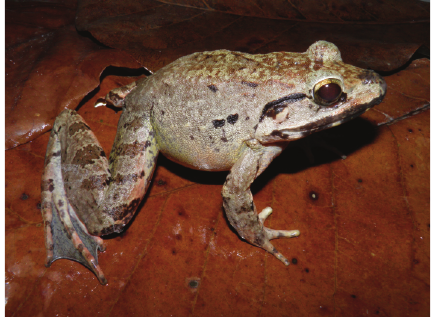
Figure 5: Elevating behaviour exhibited by L. blythii